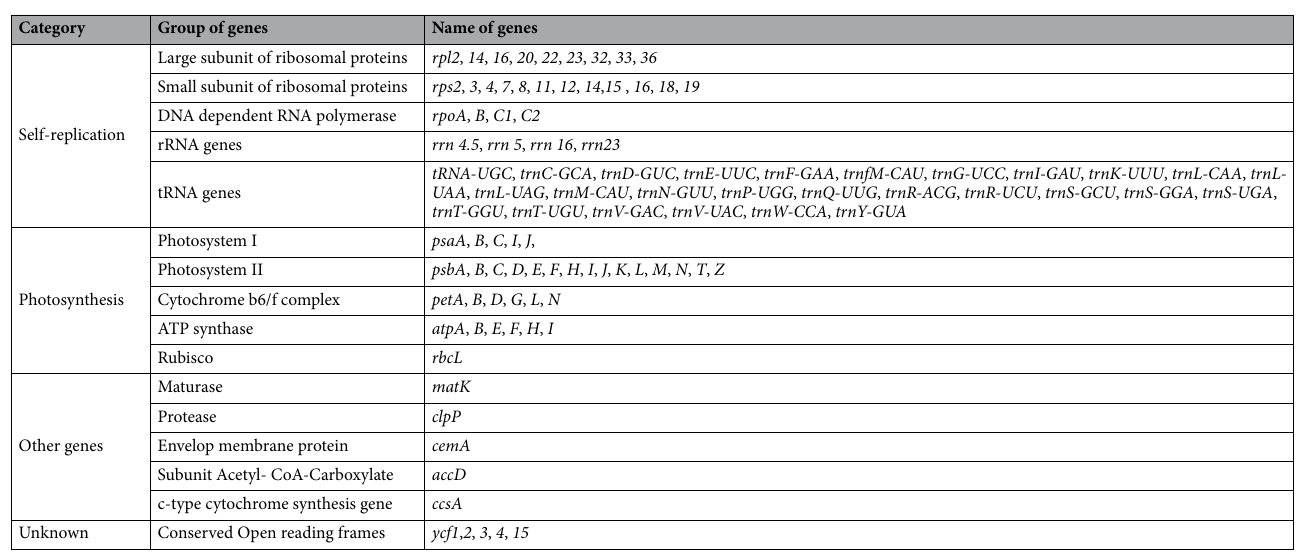
Table 2. Genes annotated in the chloroplast genome of A. marina